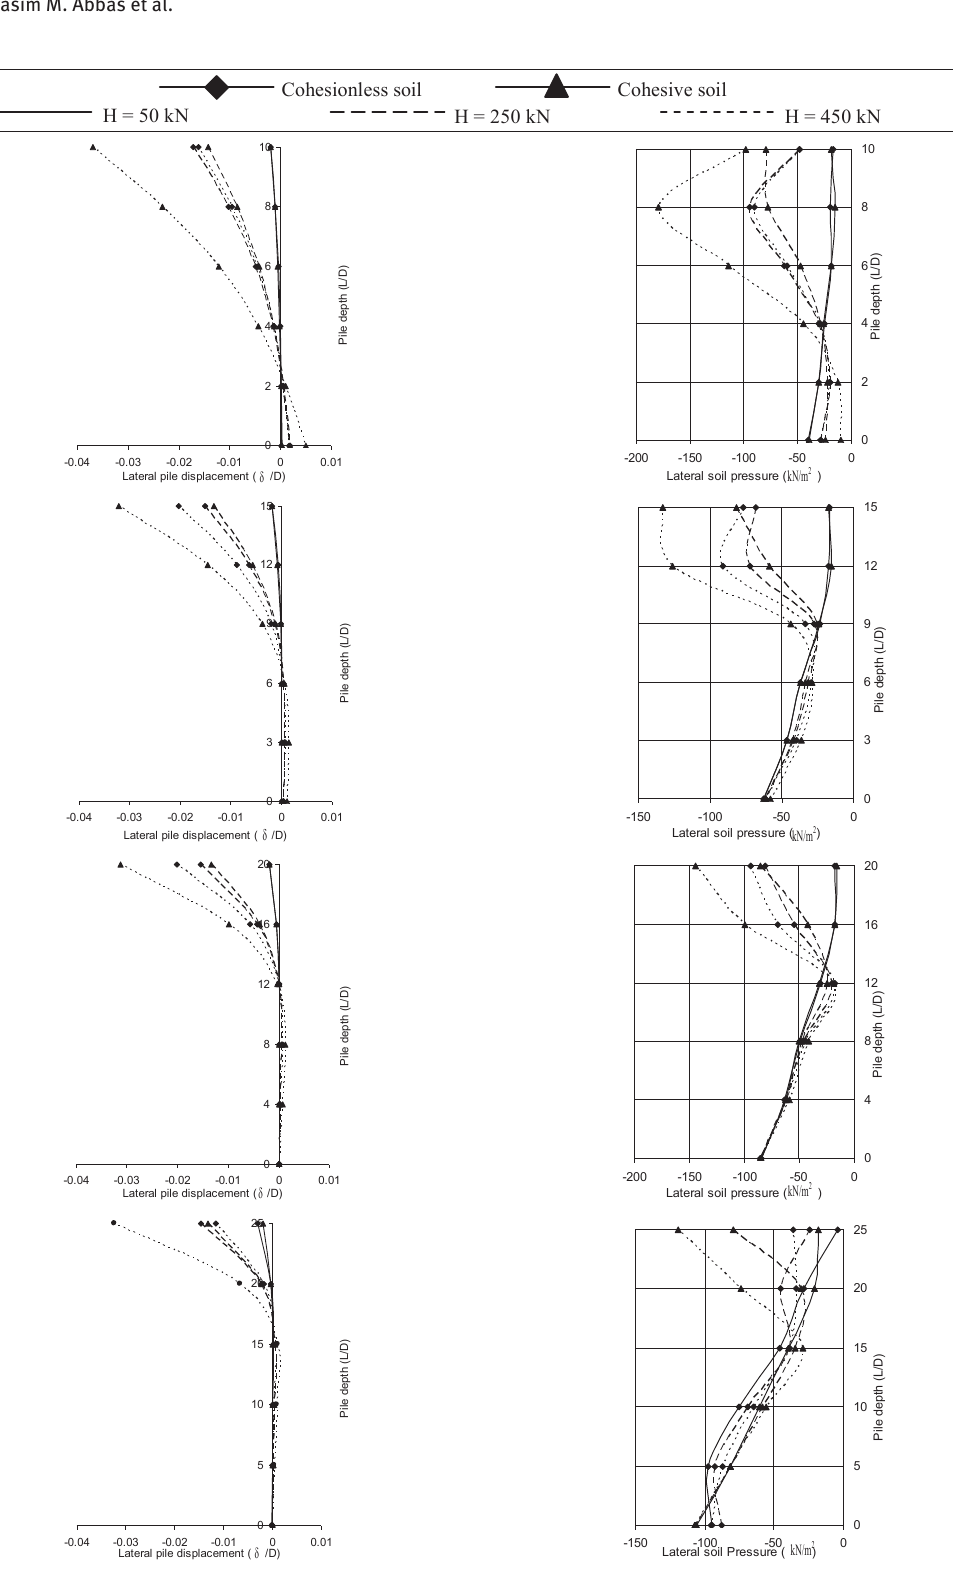
Figure 4 Influence of lateral load intensities on the lateral soil pressure distribution of pile embedded on both cohesionless and cohesive soils: (a) L = 10m, (b) L =15m, (c) L = 20 m and (d) L = 25 m